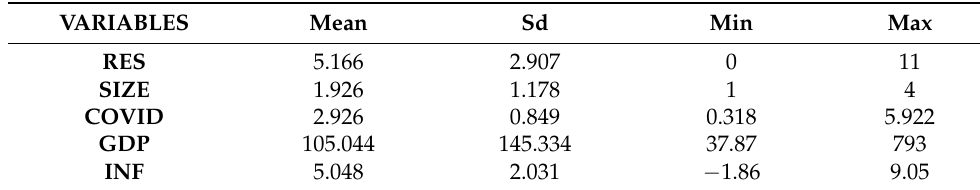
Table 3. Descriptive statistics.